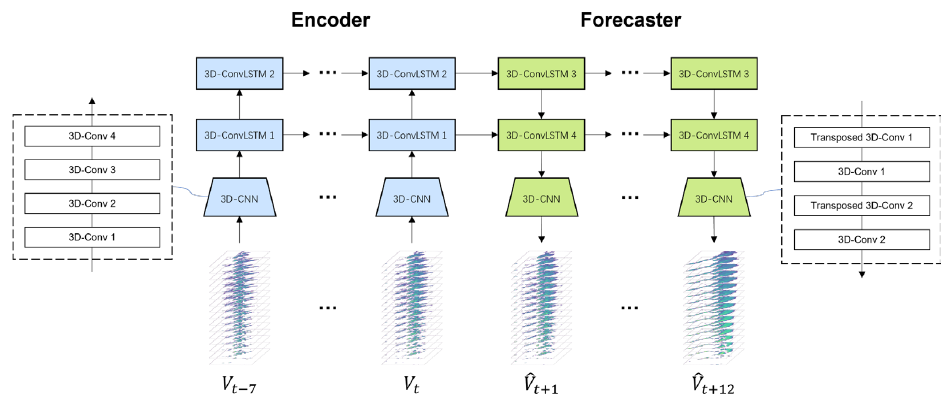
Figure 2. Architecture of proposed 3D-convolutional long short-term memory (ConvLSTM) model.